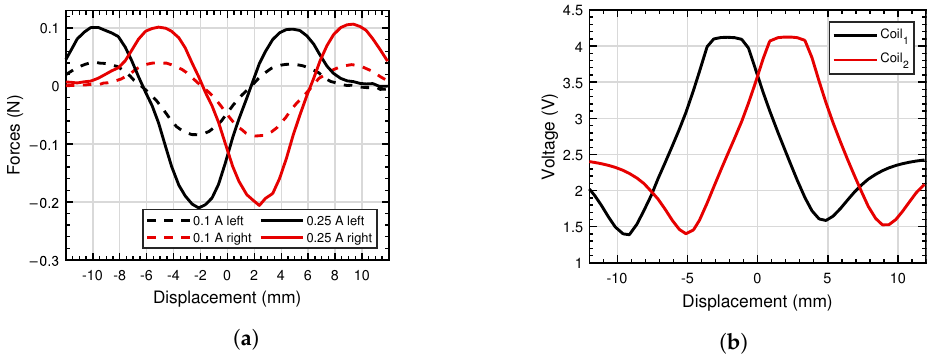
Figure 5. The measured force generated by the two coils of 0.1 A and 0.25 A over the displacement of the actuator ( a ) and the output of the Hall effect sensors measuring the magnetic field over the displacement of the actuator ( b